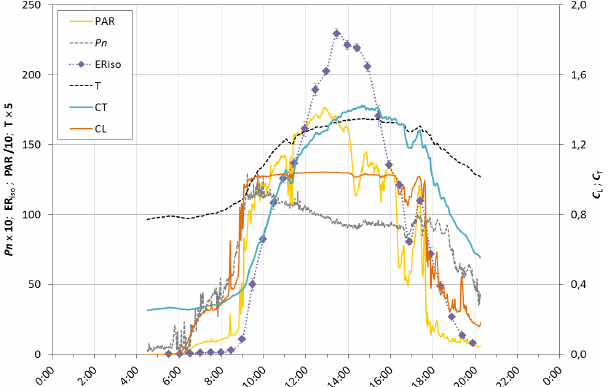
Figure 6. Diurnal variation of Qp 4 isoprene emission rate ER iso (µgCg − 1 h − 1 ) vs. C L × C T as in Guenther et al. (1993) (1 June). DM Purple diamonds are measurements between 08:00 and 14:00; or- ange diamonds are measurements between 14:30 and 20:00. Poly- nomial best fit equation and determination coefficient R 2 are given for morning (purple) and afternoon